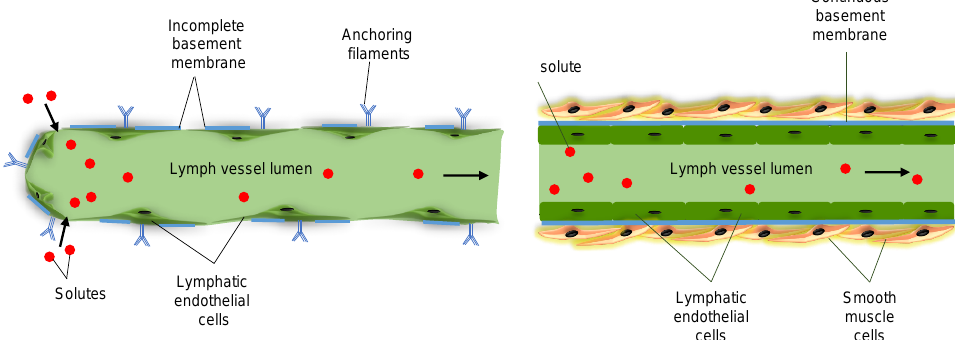
Figure 3. Structure of lymphatic vessels. ( left ) Lymphatic capillaries initiate blind-ended in the interstitial space of organs and tissues. They lack a basement membrane and have discontinuous intercellular junctions, which favors the uptake of interstitial fluid. LECs of lymphatic capillaries are attached by anchoring filaments to the extracellular matrix, which prevents vessel collapse under conditions of increased interstitial pressure. ( right ) Lymphatic collecting vessels have a continuous basement membrane and are surrounded by smooth muscle cells. The spontaneous phasic contractility of smooth muscle cells induces a coordinated propulsion of lymph.